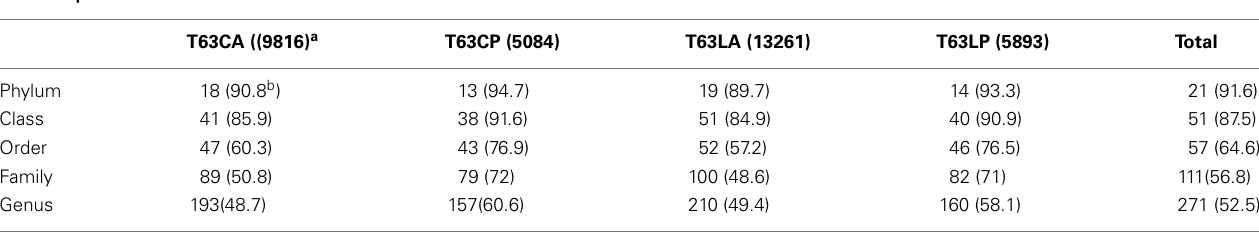
TableA2 | Number of taxa